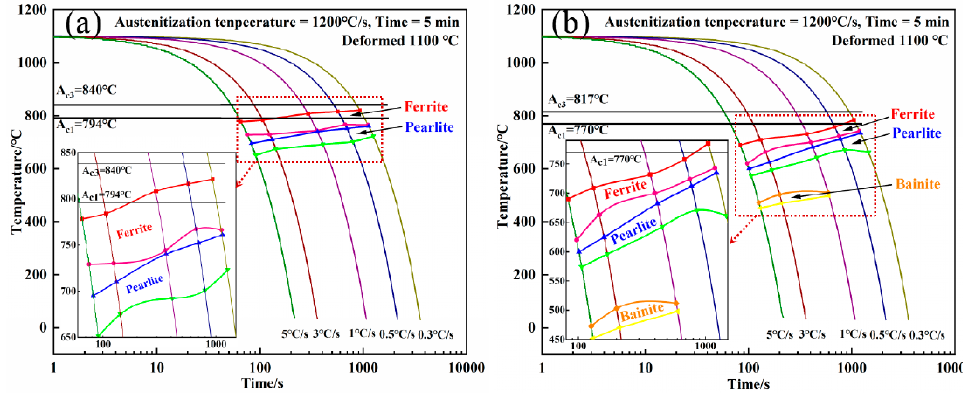
Figure 6. DCCT diagram of ( a ) steel 1# and ( b ) steel 2#.